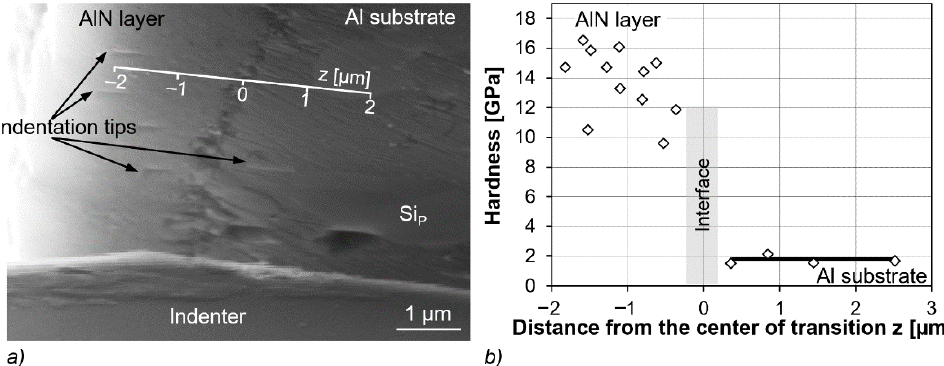
Figure 10. Nanoindentation hardness measurements in displacement-controlled mode with a max- imum depth of z max = 60 nm: ( a ) SEM image with indentation tips (exemplary); ( b ) hardness-depth profile.